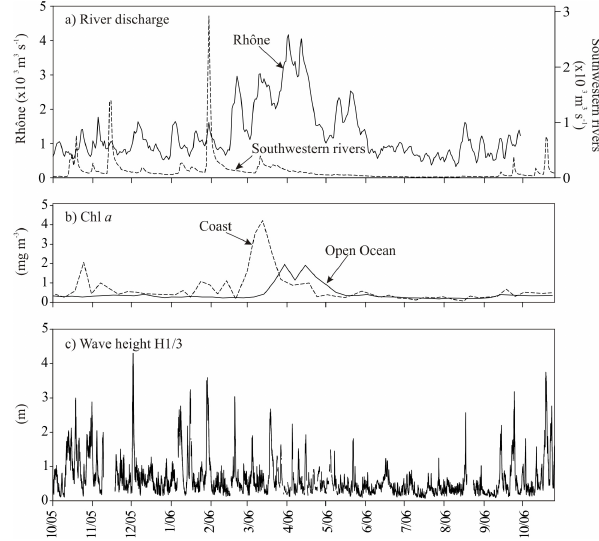
Fig. 2. (a) Daily fluvial discharges (m 3 s − 1 ) of the Rhˆone and the Southwestern rivers (H´erault, Orb, Aude, and Tˆet), (b) mean chlorophyll a (chl a) concentration (mgm − 3 ) recorded at coastal station and open ocean and (c) significant wave Heights H1/3 (m) recorded at the S`ete wave buoy offshore